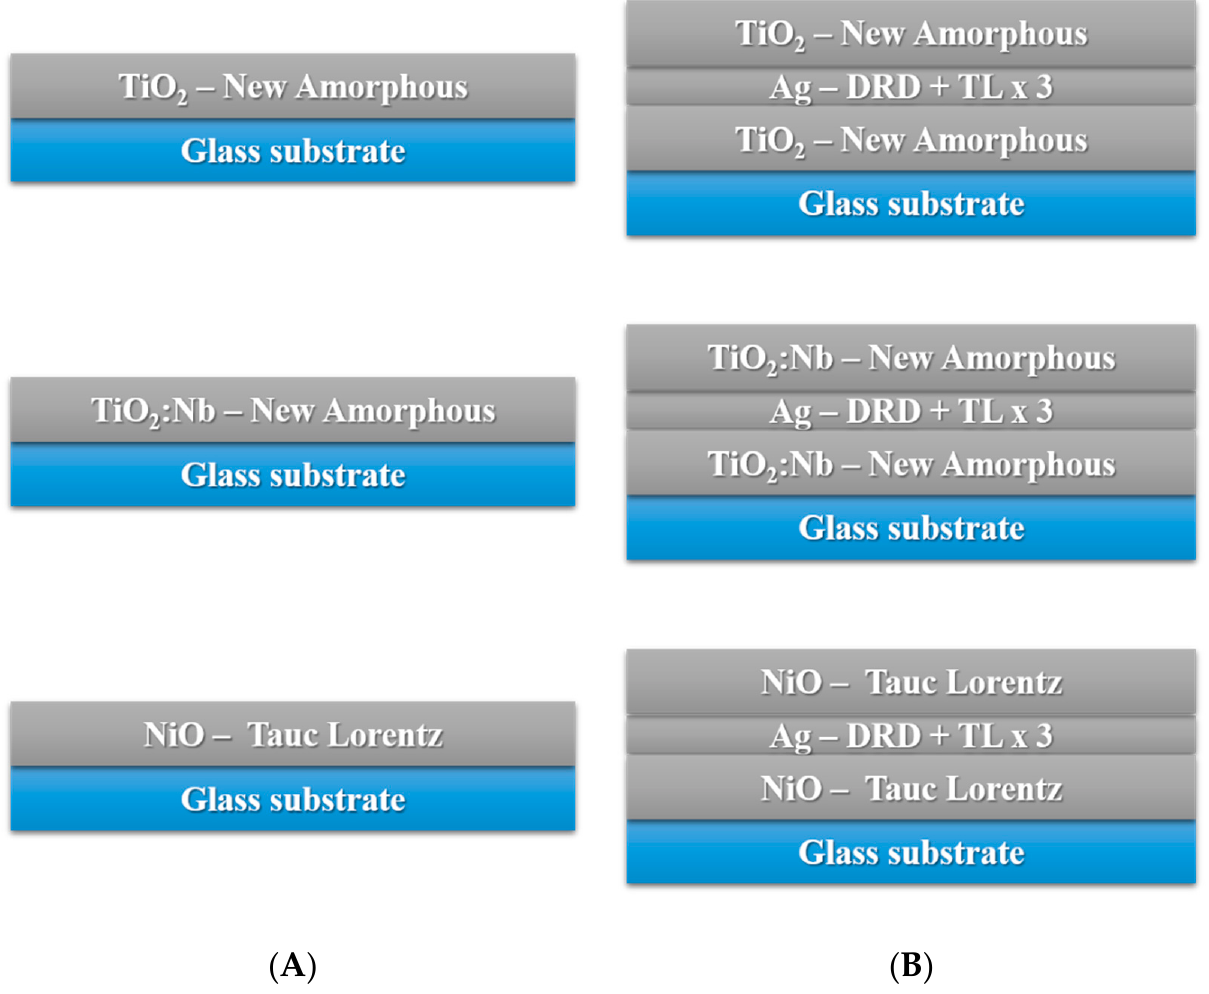
Figure 5. Ellipsometric models for single layers ( A ) and O/M/O three-layer structures ( B